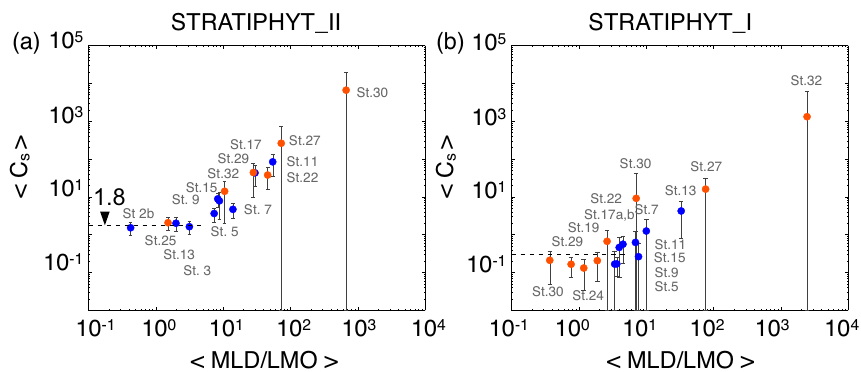
Fig. 9. Station-averaged proportionality constants, C s , that ensure ε/ε ∗ s = C s throughout the mixed layer and avoiding the first 5m close to the surface because of possible surface wave breaking contamination. Graphs presented for (a) the STRATIPHYT-II cruise (6 April– 3 May 2011) , and (b) the STRATIPHYT-I cruise (15 July–9 August 2009). ε is the TKE dissipation rate, and ε ∗ s the related wind stress similarity variable, defined in Eq. (4). The horizontal axis depicts the station-averaged ratio of the mixed layer depth and the Monin–Obukhov length, MLD/LMO. The angle brackets indicate a station-average, and the error bars indicate the standard deviation of the depicted value. The numbering of the corresponding station is also indicated. The stations south of 48 ◦ N are depicted in blue filled circles, the stations north of 48 ◦ N are depicted in orange filled circles. The stations north of 48 ◦ N in STRATIPHYT-II have larger MLDs than the maximum depth measured by the SCAMP, and at those stations we have performed the station-averaged C s down to 100m and we have assumed that MLD is 300m to represent h MLD/LMO i . We have not considered stations with less than 3 profiles or the stations where the anemometer was not